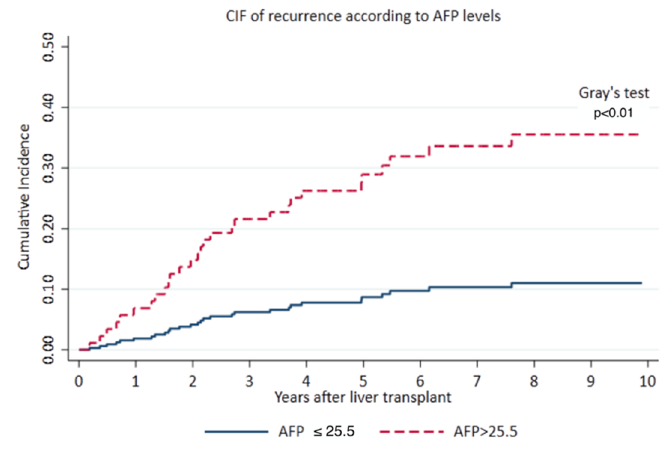
Figure 1. 10-year Cumulative incidence function (CIF) of recurrence according to AFP level.